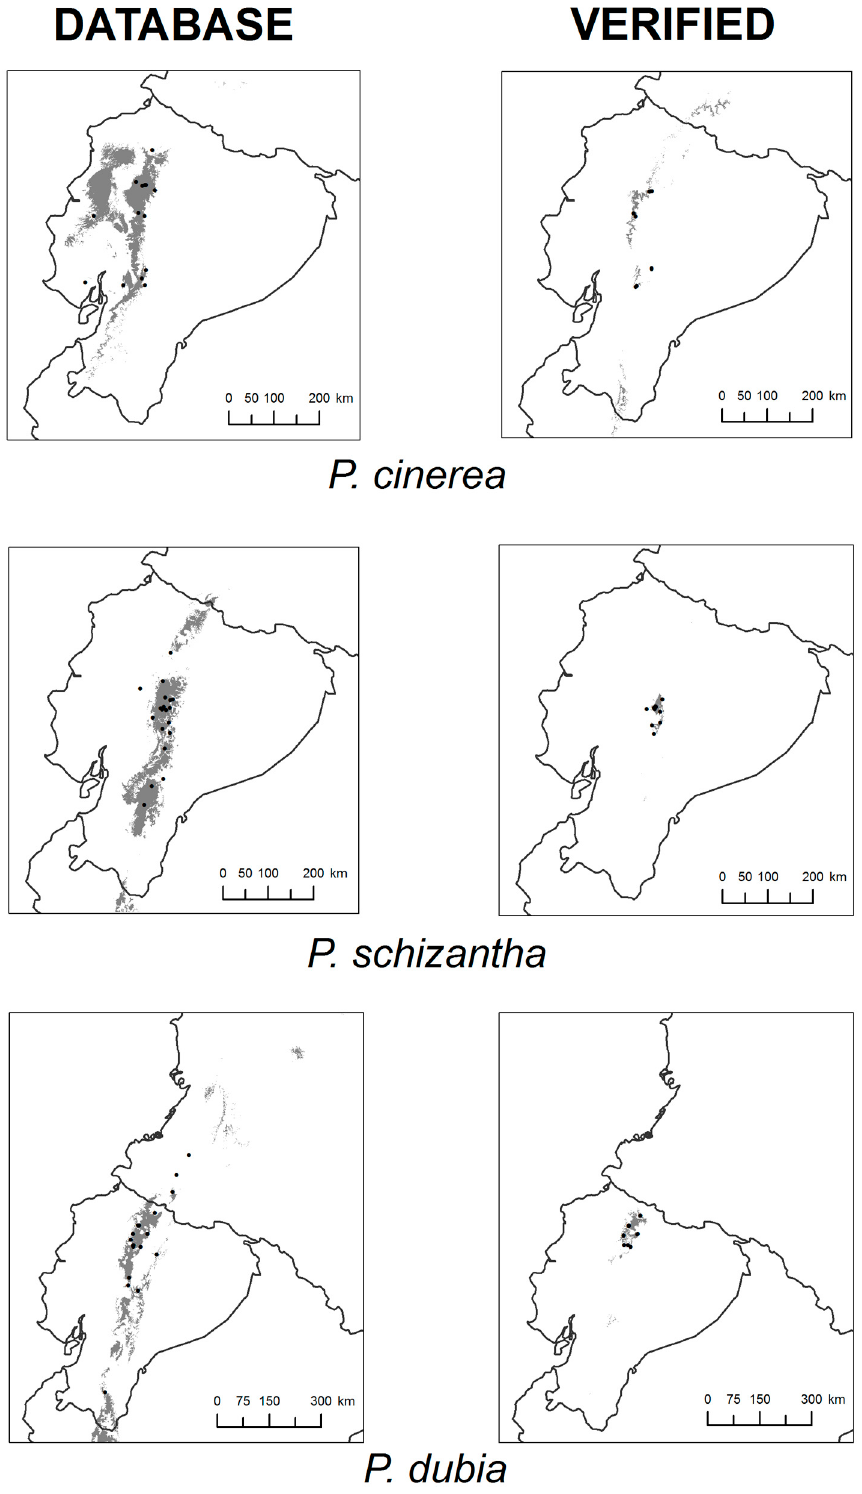
Figure 1. Distribution maps for Phaedranassa cinerea , P. schizantha and P. dubia (Amaryllidaceae) in Ecuador. Darker areas indicate predicted potential ranges based on online database records ( left ) and verified records ( right ). Points show the actual species distribution. Conflicts of Interest: The authors declare no conflict of interest.